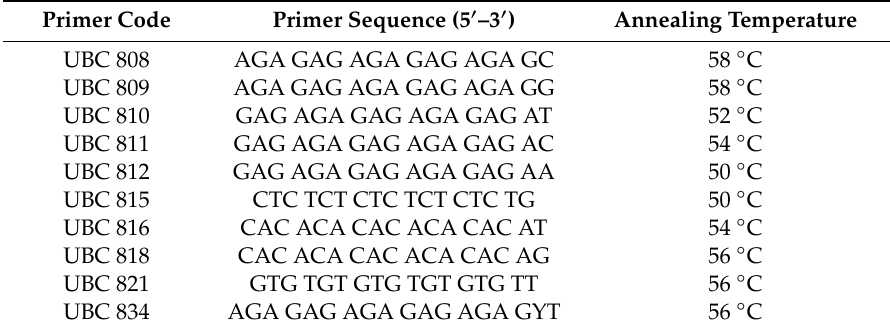
Table 7. Sequence of 10 Inter Simple Sequence Repeat (ISSR) primers used to determine the genetic stability of V. dentatum plantlets produced from encapsulated shoot tip